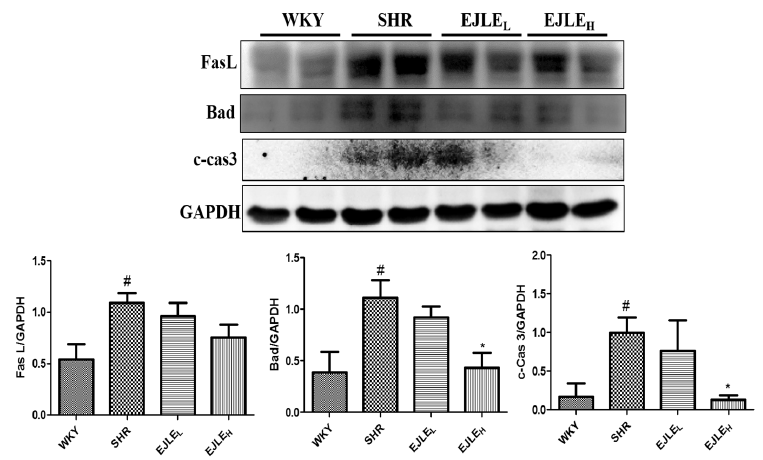
Figure 3. Effect of EJLE on apoptotic signaling mediators in the heart tissue sections of SHR animals. Representative Western blot depicting the changes in the levels of FasL, Bad, c-Cas3 proteins involved in apoptosis in normotensive rats (WKY), spontaneously hypertensive rats (SHRs) and SHRs supplemented with low dose (EJLE L ) and high dose (EJLE H ) of EJLE. Results were analyzed by one-way ANOVA using Tukey test with GraphPad Prism software (Version 5.0). # ( p < 0.05) indicate significant differences when compared to normotensive WKY group (SHRs vs. WKY); whereas * ( p < 0.05) indicate significant differences when compared to SHR group.